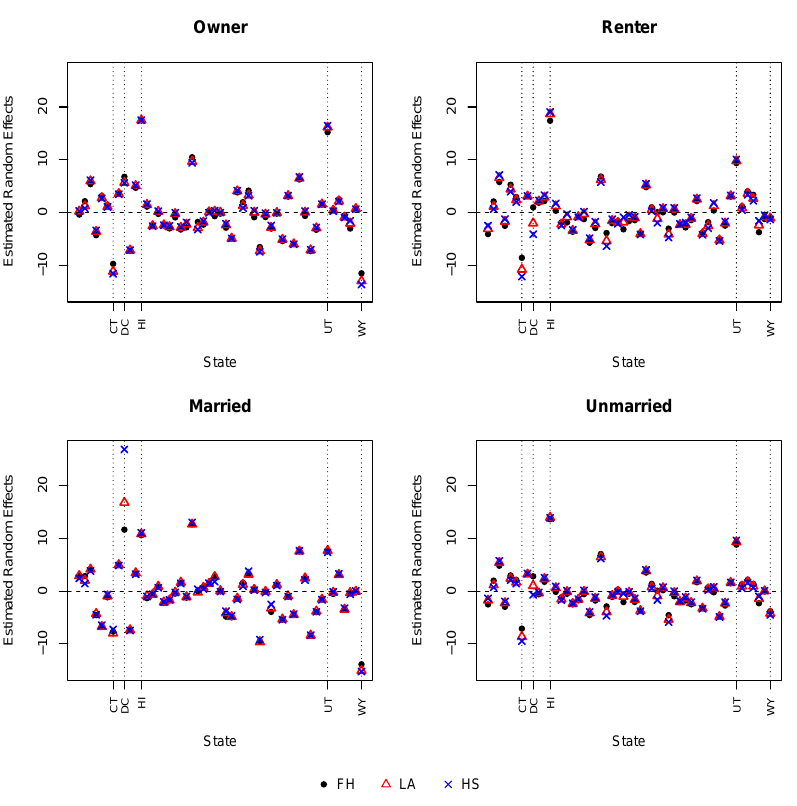
Figure 1. Estimated random effects from FH, LA, and HS models for four subgroups in all